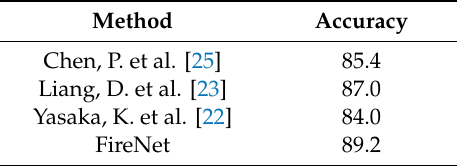
Table 5. Comparison to state-of-the art